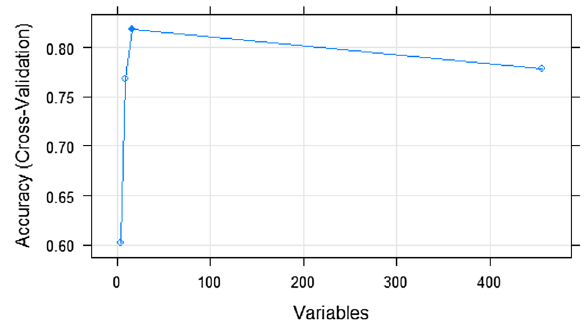
Figure 5. Plot of RFE-CV result.